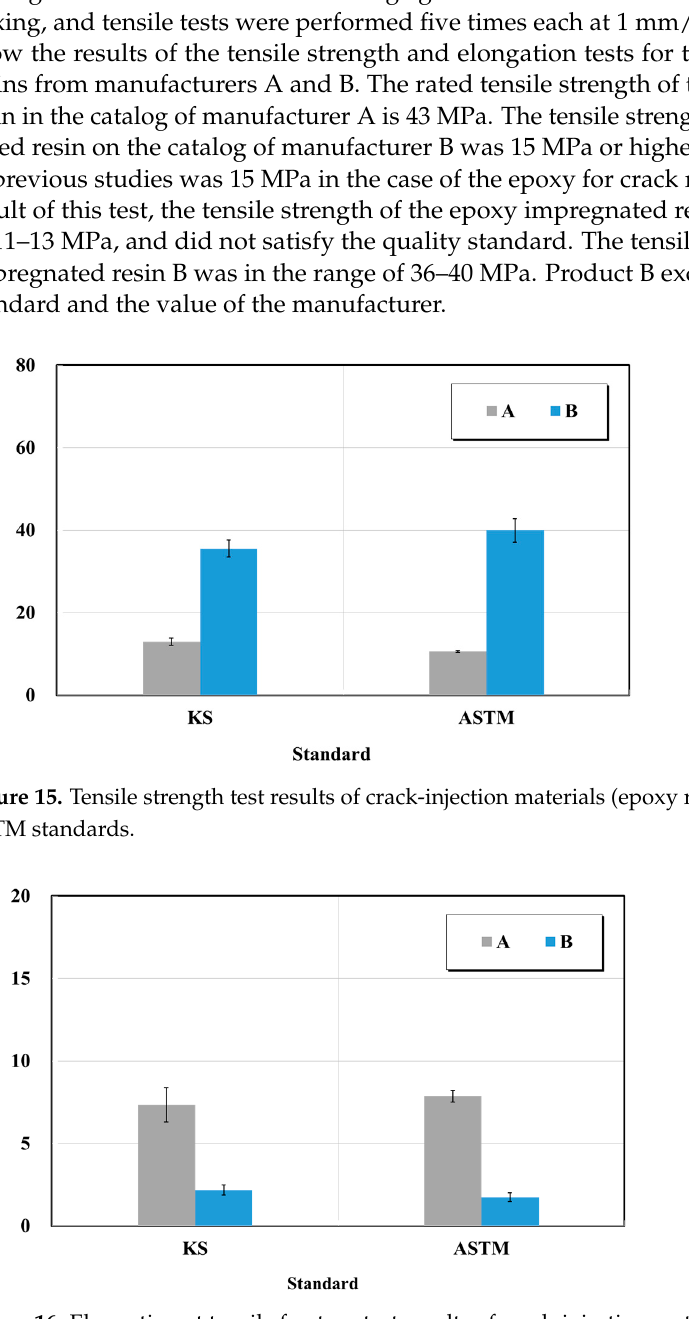
Figure 16. Elongation at tensile fracture test results of crack-injection materials (epoxy resin) based on the KS and ASTM standards. on the KS and ASTM